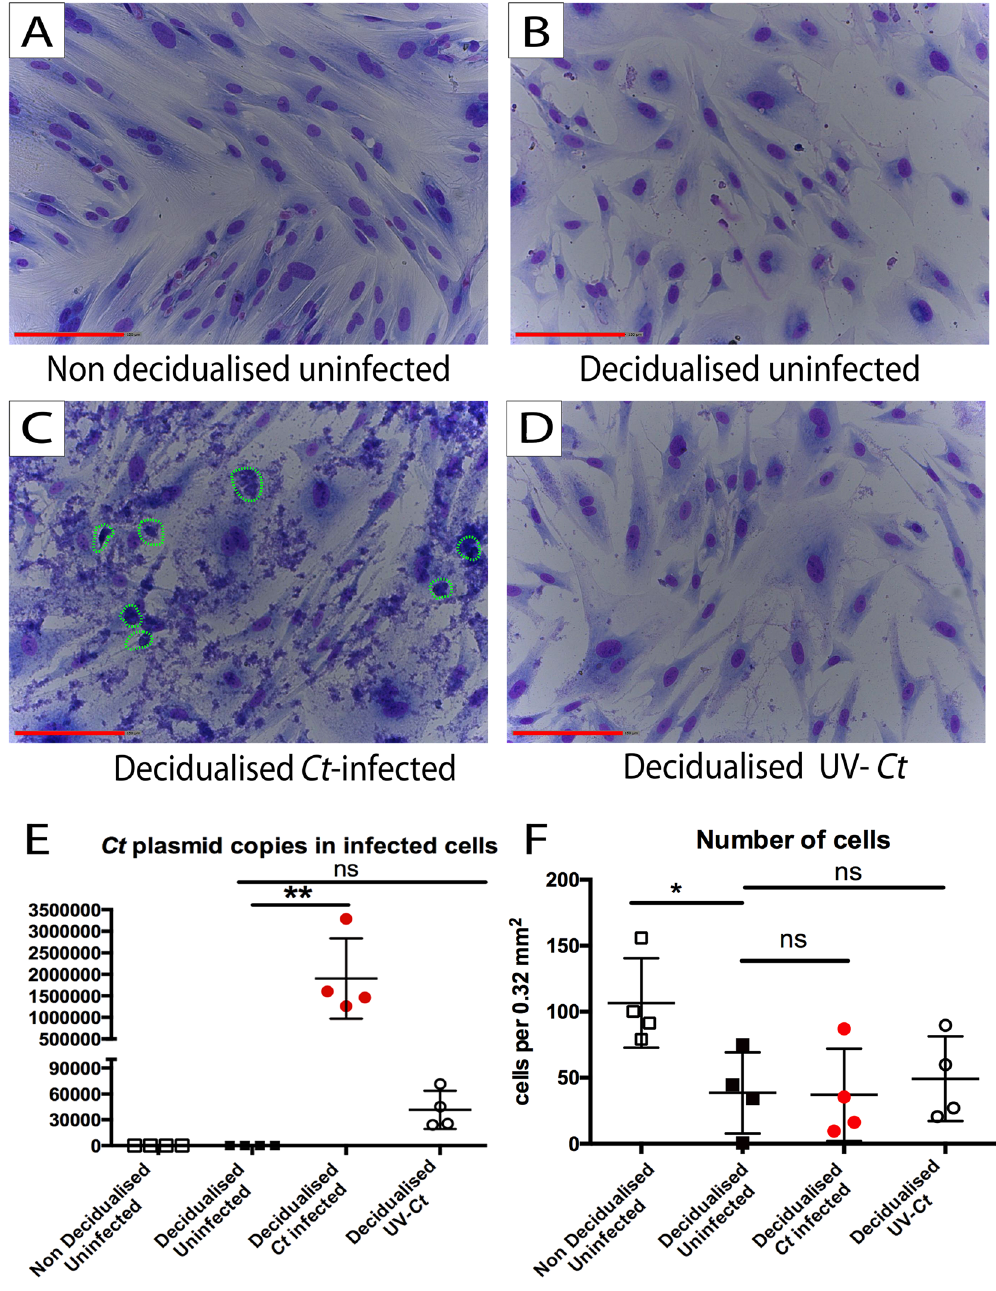
Figure 1. Ct infects decidualised ESC. ESC were infected with Ct MOI 2 following an in-vitro decidualisation protocol. Non decidualised uninfected ESC, uninfected decidualised ESC and UV-Ct treated ESC were used as controls. 48 hours post infection DNA was collected for qPCR and cells were stained with Giemsa. Cell counts were conducted in 15 fields of view per well measuring 0.32 mm 2 each. ( A ) Non decidualised uninfected ESC were elongated and thin. ( B ) Decidualised uninfected ECS became rounder and larger compared to non decidualised ESC. ( C ) Ct infected decidualised ESC displayed signs of infection and contained inclusions that were stained purple by Giemsa stain (highlighted by green circles). ( D ) UV-Ct treated decidualised ESC did not contain chlamydial inclusions and resembled uninfected decidualised ESC in appearance. ( E ) 25.000–75.000 Ct plasmid DNA copies were detected in UV-Ct treated ESC. Ct infected ESC had a significantly higher number of 1.200.000–3.200.000 plasmid copies per sample, indicating proliferation of Ct only in infected cells (RM one-way ANOVA-Friedman’s test with Dunn’s multiple comparisons test, p = 0.0094, n = 4). ( F ) Cell counts on Giemsa stained ESC indicated that decidualised uninfected cells were significantly fewer compared to non- decidualised controls (RM one-way ANOVA-Friedman’s test with Dunn’s multiple comparisons test, p = 0.0185, n = 4). In contrast, UV-Ct treated cells and Ct infected cell numbers were similar to uninfected decidualised ESC. Scale bars equal 200 μ m. Graphs show the mean and standard